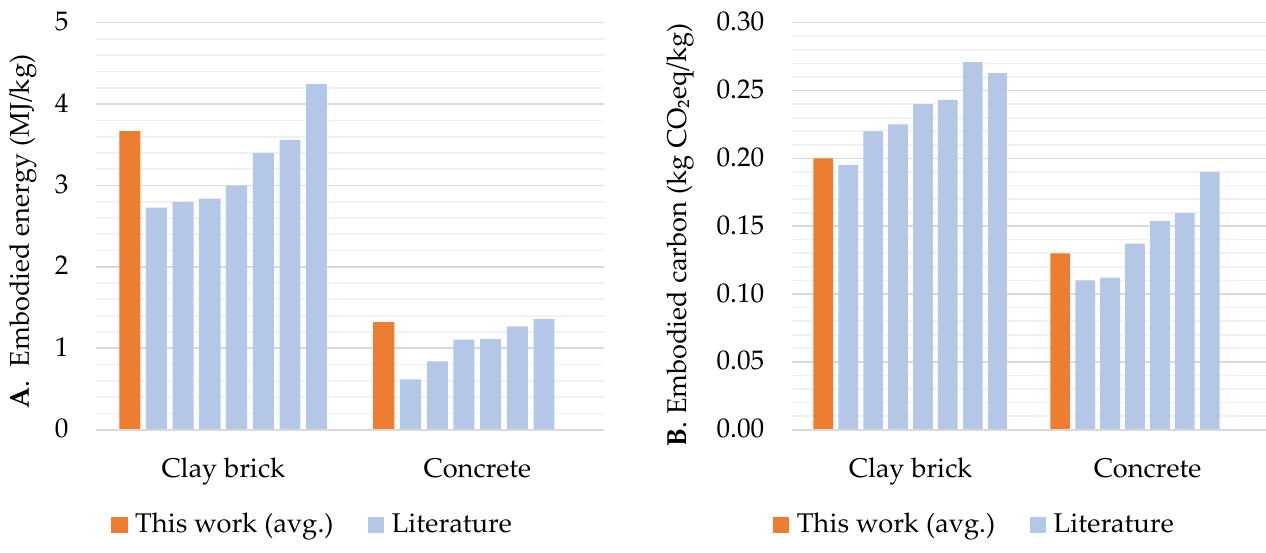
Figure 7. Comparison with literature data of the average embodied energy ( A ) and carbon ( B ) of bricks and concrete. Table 9. Literature values for the embodied energy and carbon of brick and concrete products.